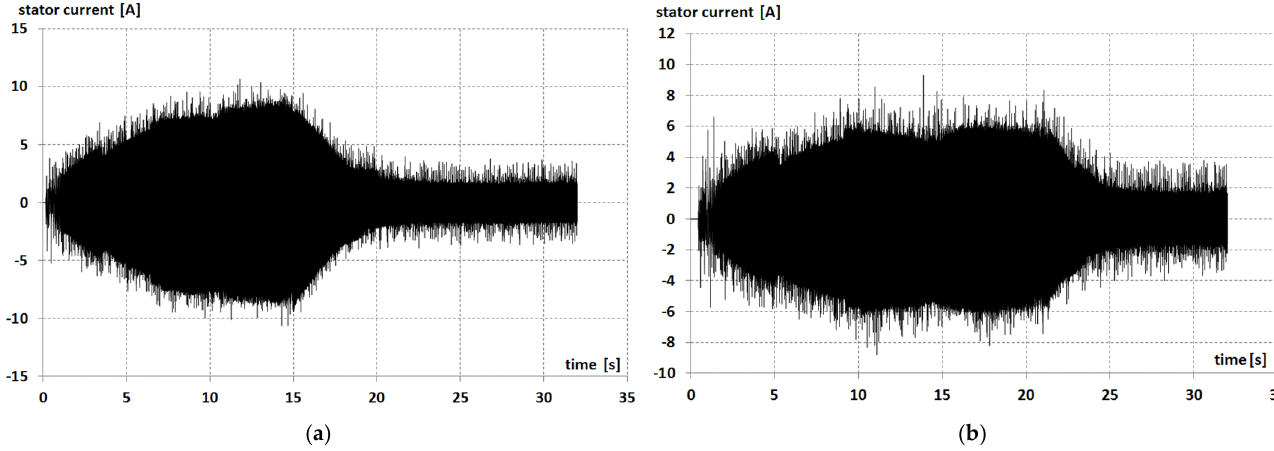
Figure 11. The measured waveforms of the instantaneous value of the current in the stator phase winding at the frequency start-up of the motor with an initial voltage of zero and a frequency rise time of ( a ): 5 s and ( b ): 7 s, for the motor with additional inertia mass ( J = 0.00454 kg m 2 ). ( a ): caption, ( b ) caption.